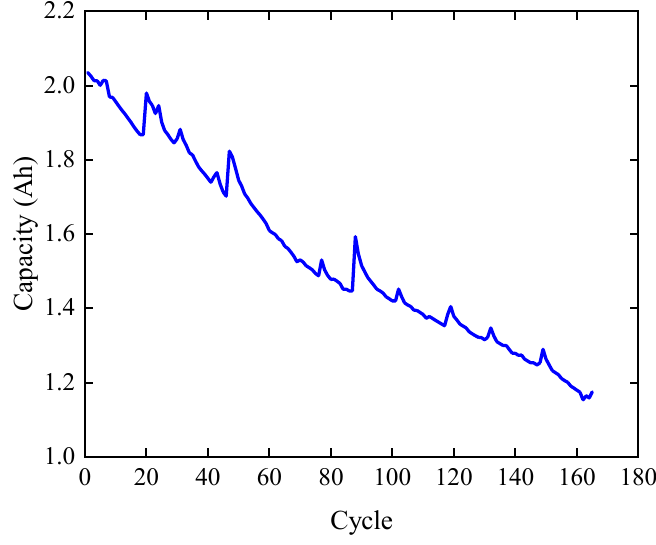
Figure 3. Relationship between the actual remaining capacity and cycles.